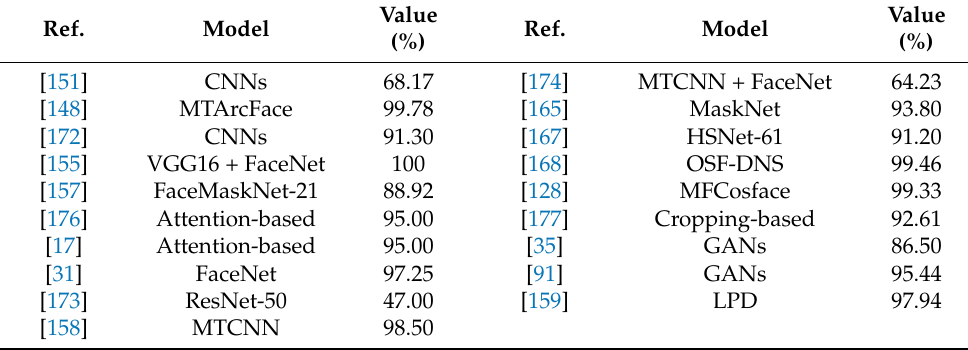
Table 5. A comparison of accuracies achieved by MFR approaches.